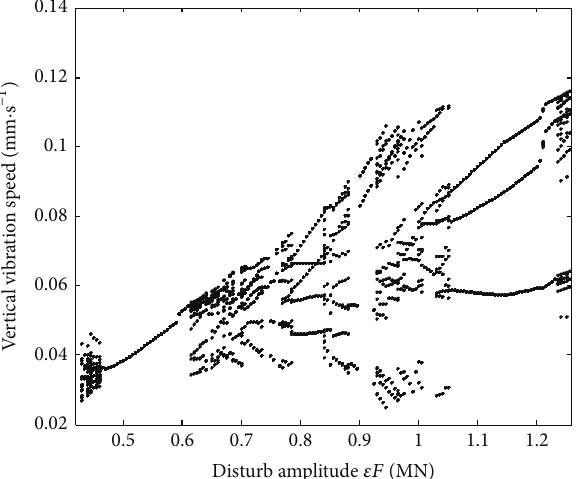
Figure 10: Bifurcation characteristics of coupling system with disturb amplitude 𝜀𝐹 when 𝜎 = 50